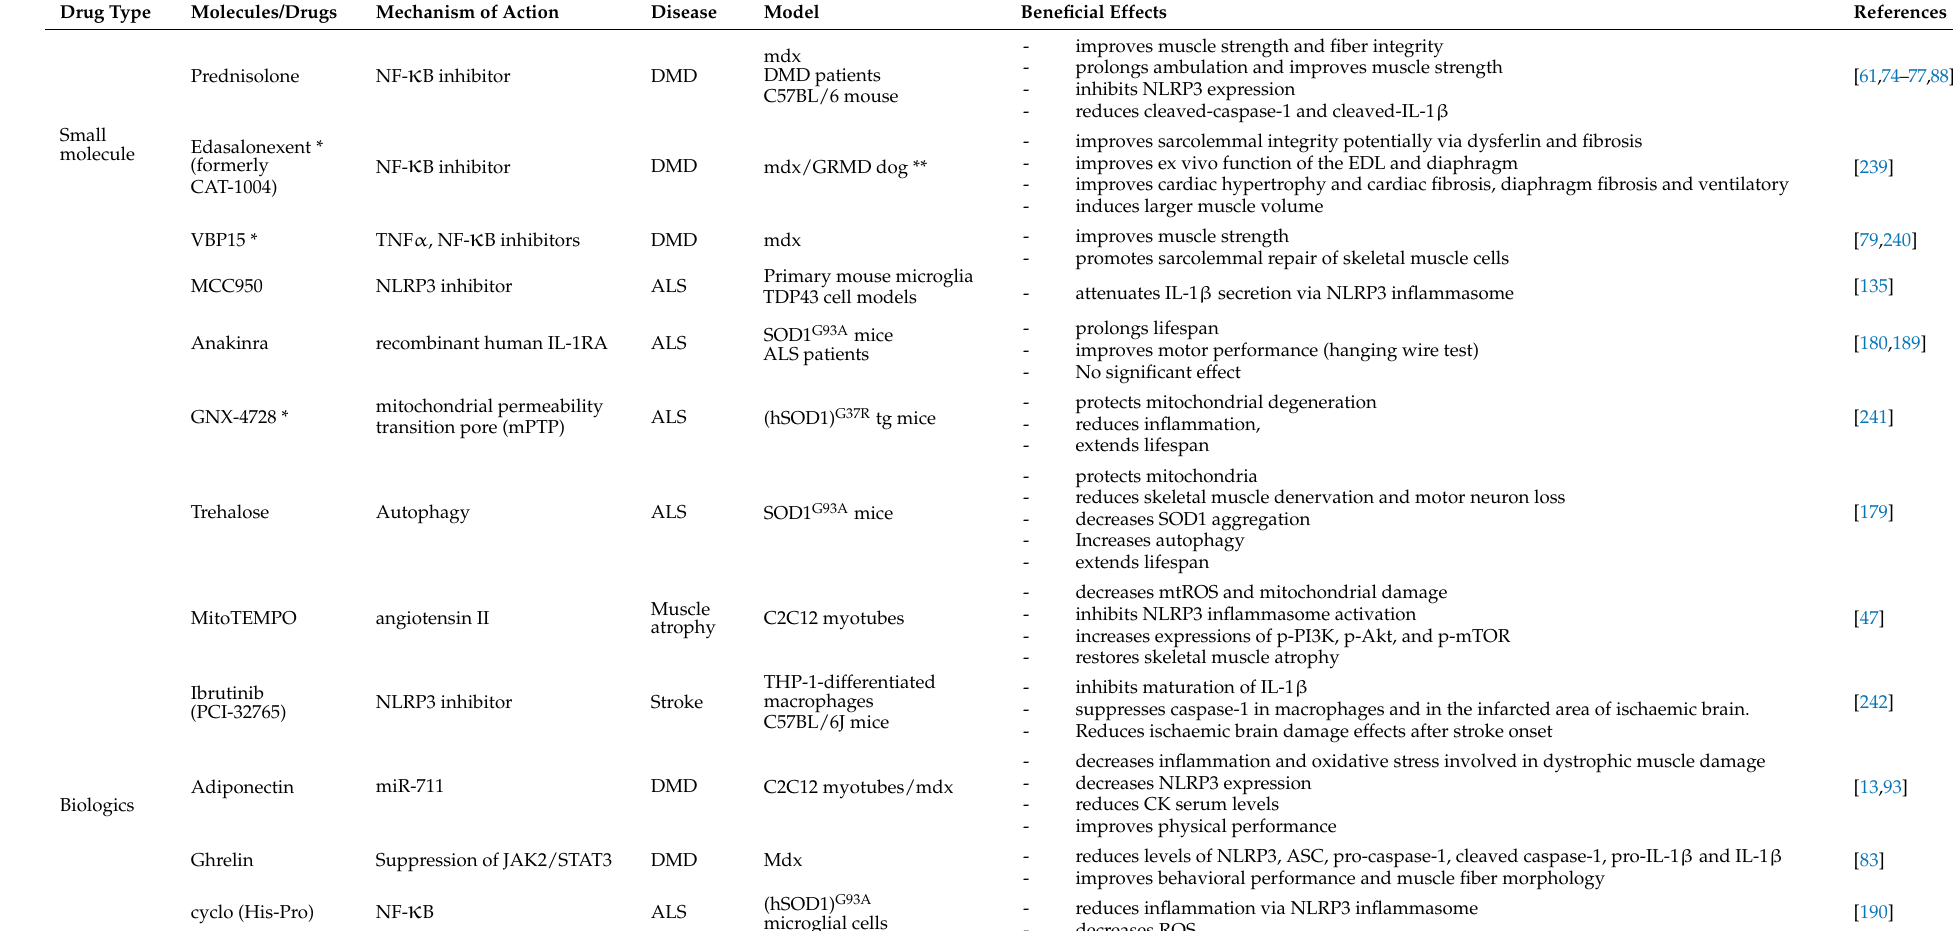
Table 1. Therapeutic targeting of the NLRP3 inflammasome in neuromuscular